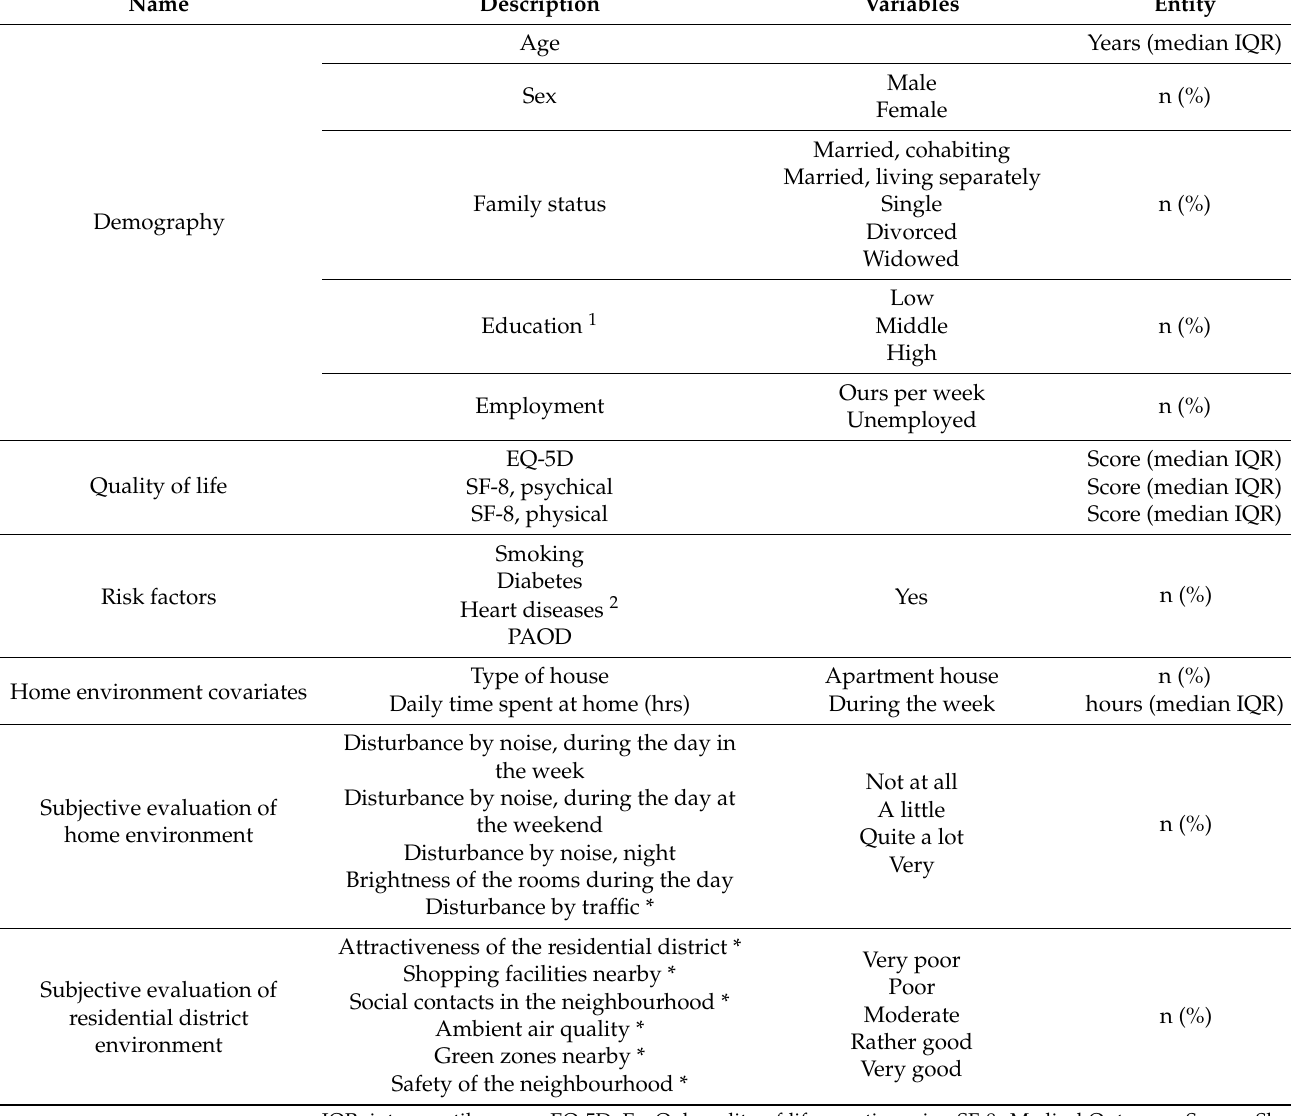
Table 1. Overview of used data in this